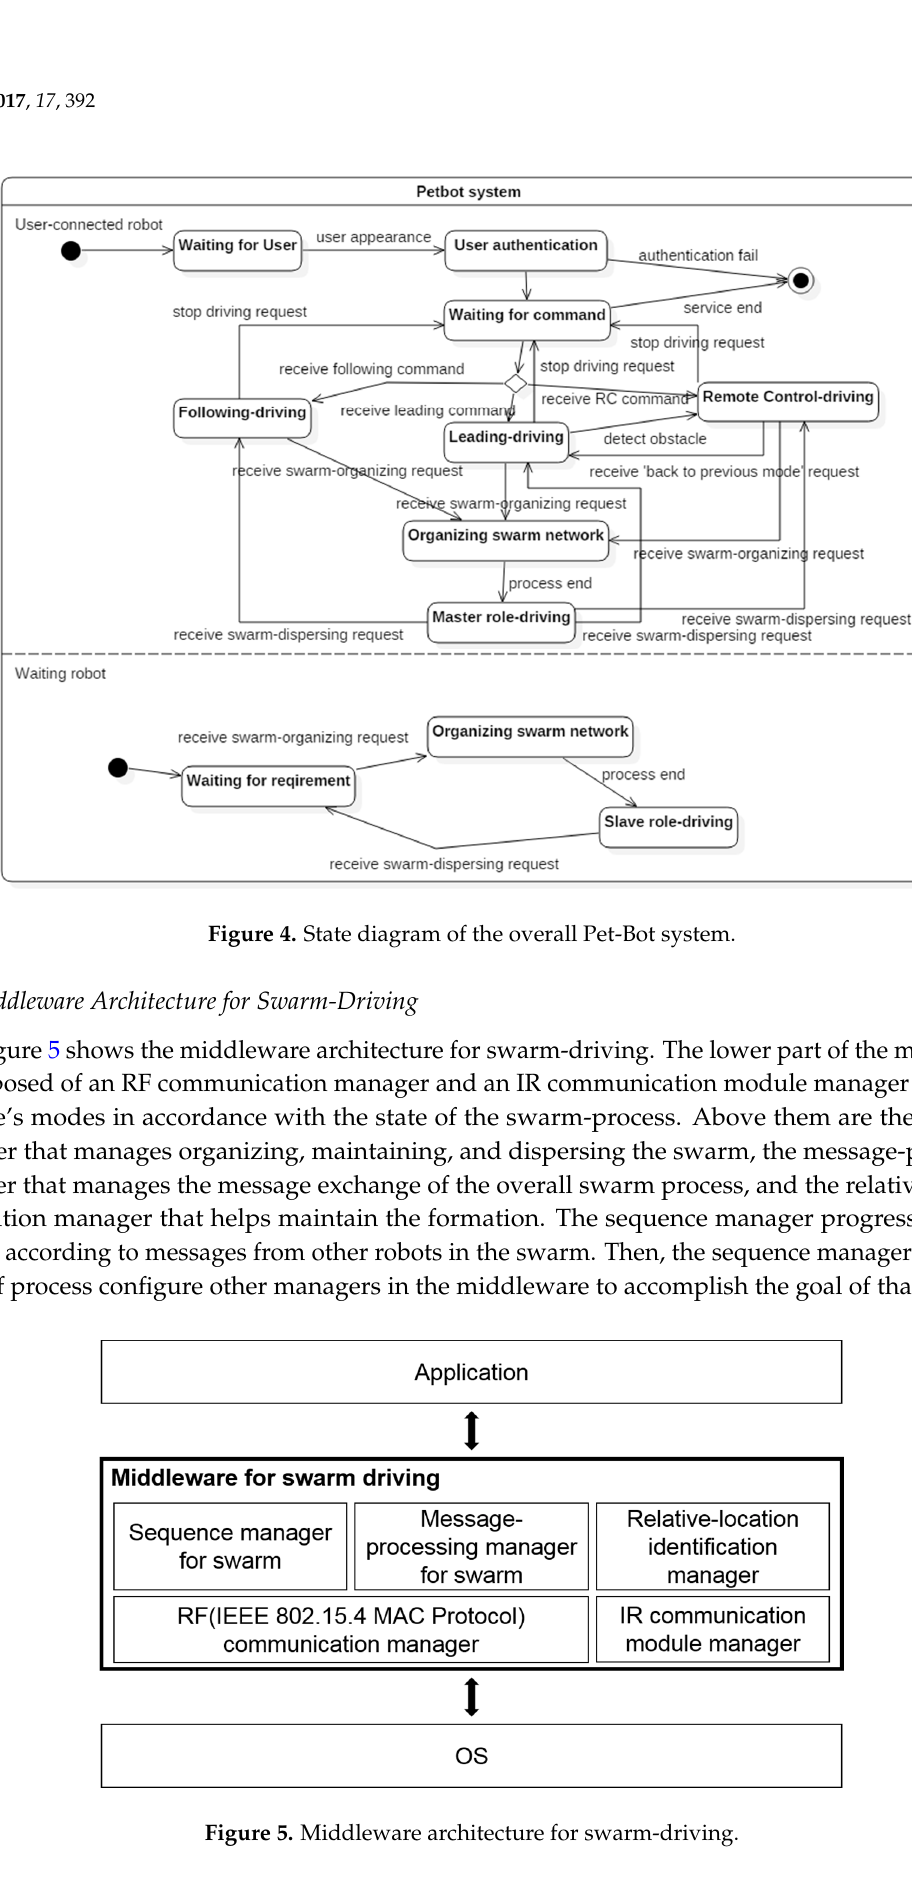
Figure 5. Middleware architecture for swarm-driving.